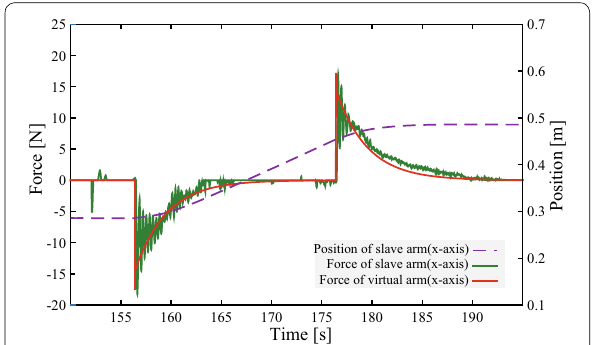
Fig. 10 Force and position of slave arm without force feedback